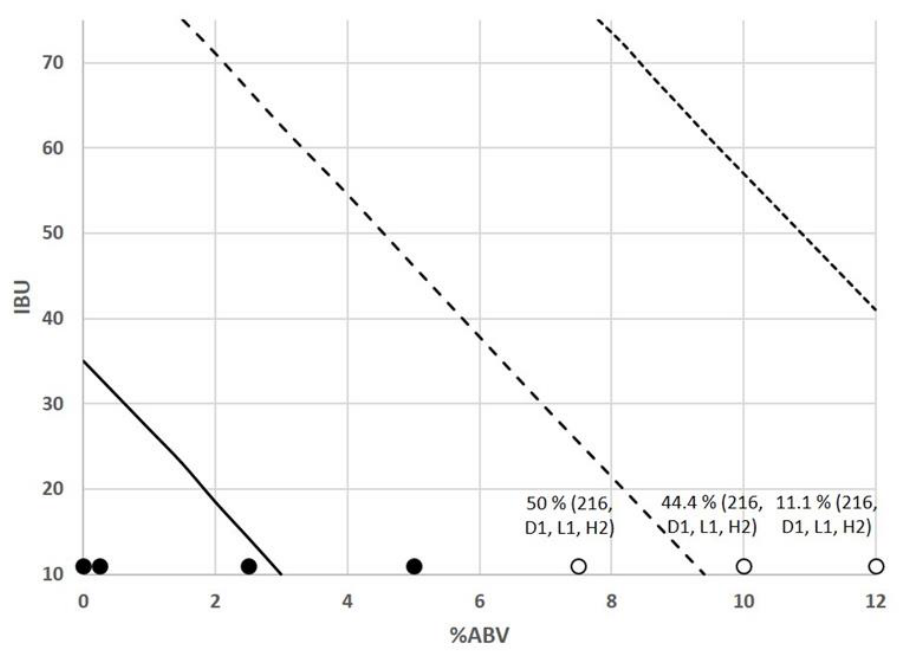
Figure 3. Contour plots for the observed growth responses and predicted probabilities (P = 0.1 ( ⋯⋯ ), P = 0.5 (- - -), and P = 0.9 (—)) for the microbial spoilage of craft beer as a function of % ABV and IBU. Values of pH and % YFE were set at 4.2 and 2.37, respectively. (●) P = 1 (growth), ( ○ ) P = 0 (no growth). Percentages indicate the proportion of strains showing growth, being described between brackets.